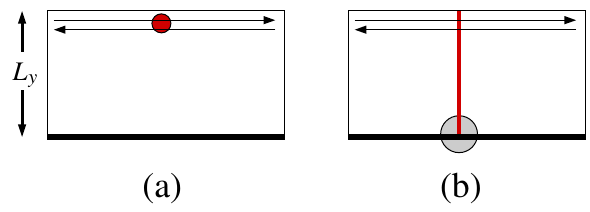
FIG. 5. We consider the system in a strip geometry with finite width L y in the y direction. We assume that the lower edge is gapped, while the upper edge is gapless and described by (22). The system has two types of scaling operators: (a) charge neutral operators (27) acting on the upper edge and (b) charged opera- tors of the form e il T (cid:5) . Operators of type (b) can only appear as a low-energy description of a tunneling process in which a quasi- particle of type l tunnels from the upper edge to the lower edge and is subsequently